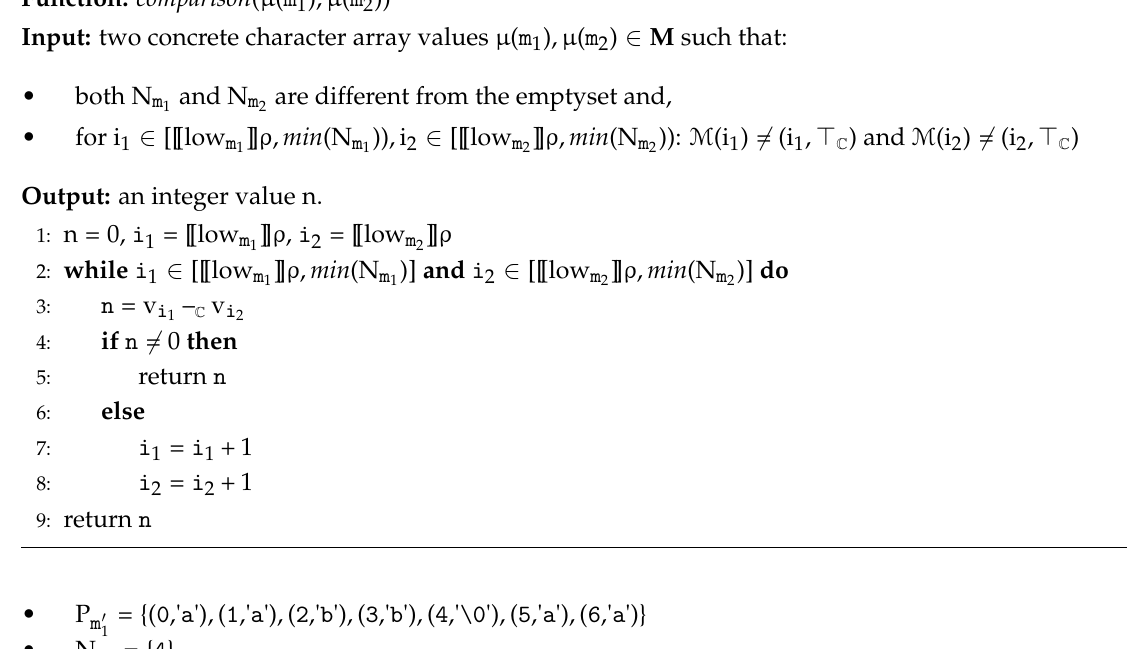
Algorithm 1 Lexicographic comparison of concrete character array